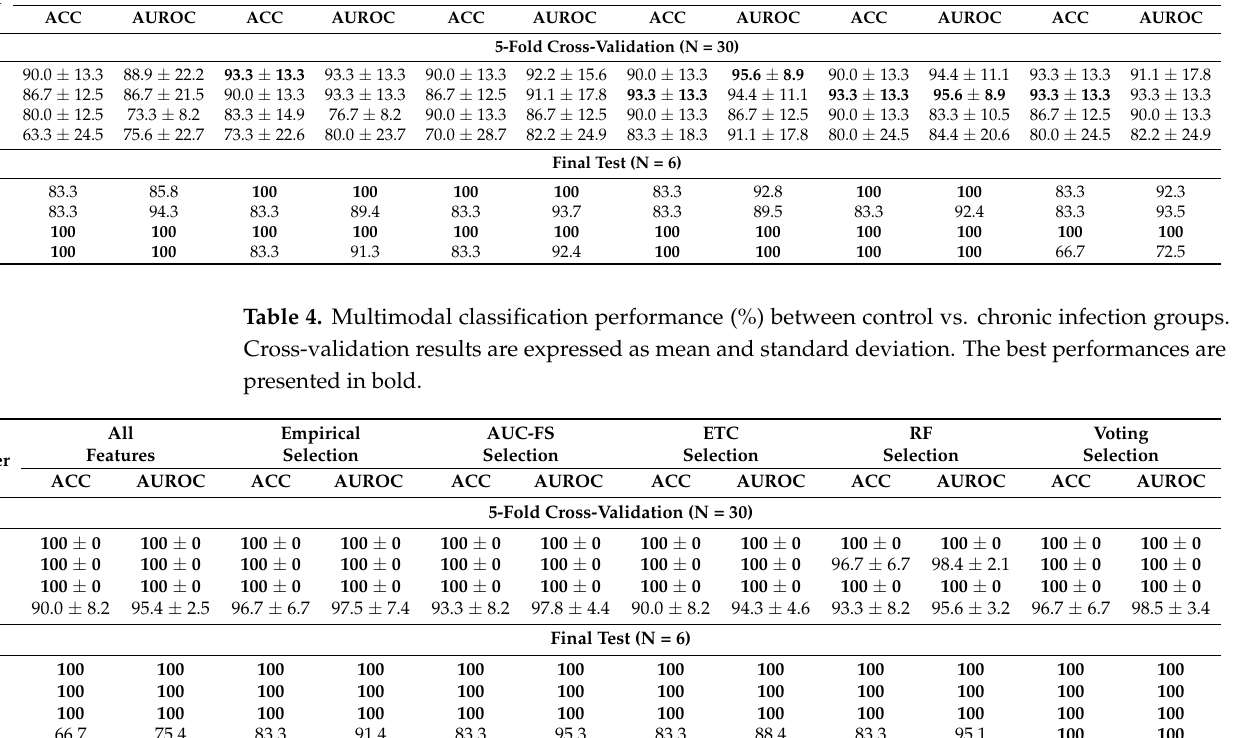
Table 5. Multimodal classification performance (%) between control vs. general infection (acute